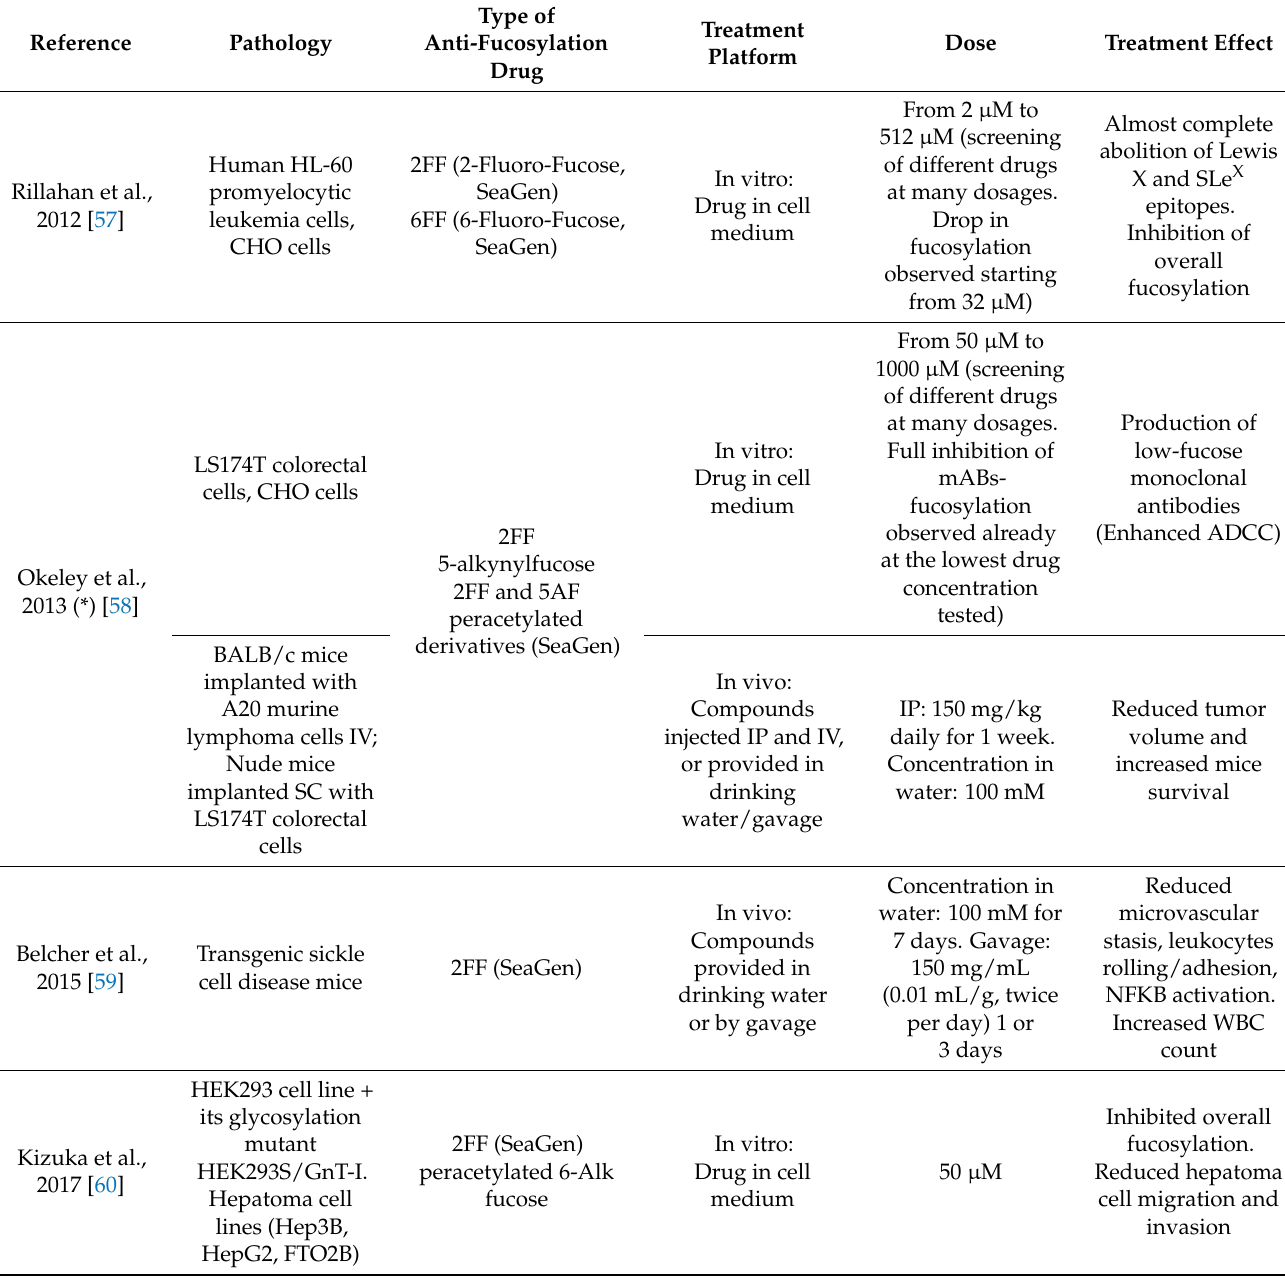
Table 1. Pre-clinical and clinical studies evaluating the effects of anti-fucosylation drugs. Only one clinical trial has been published, while the other studies were performed on cells and murine models of various cancers and sickle-cell